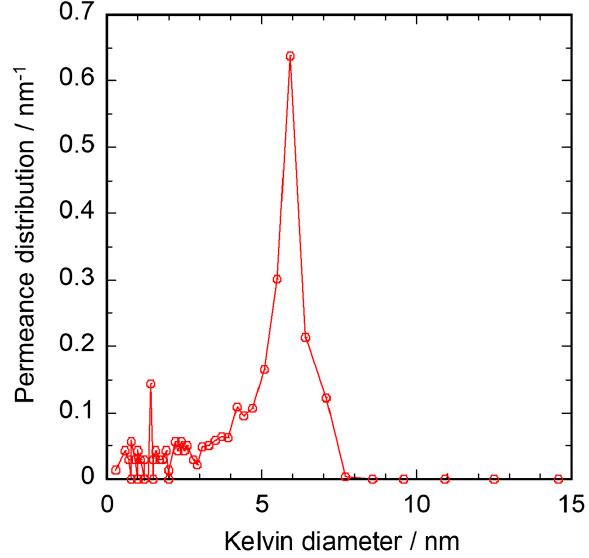
/ α -Al 2 O 3 porous capillary.